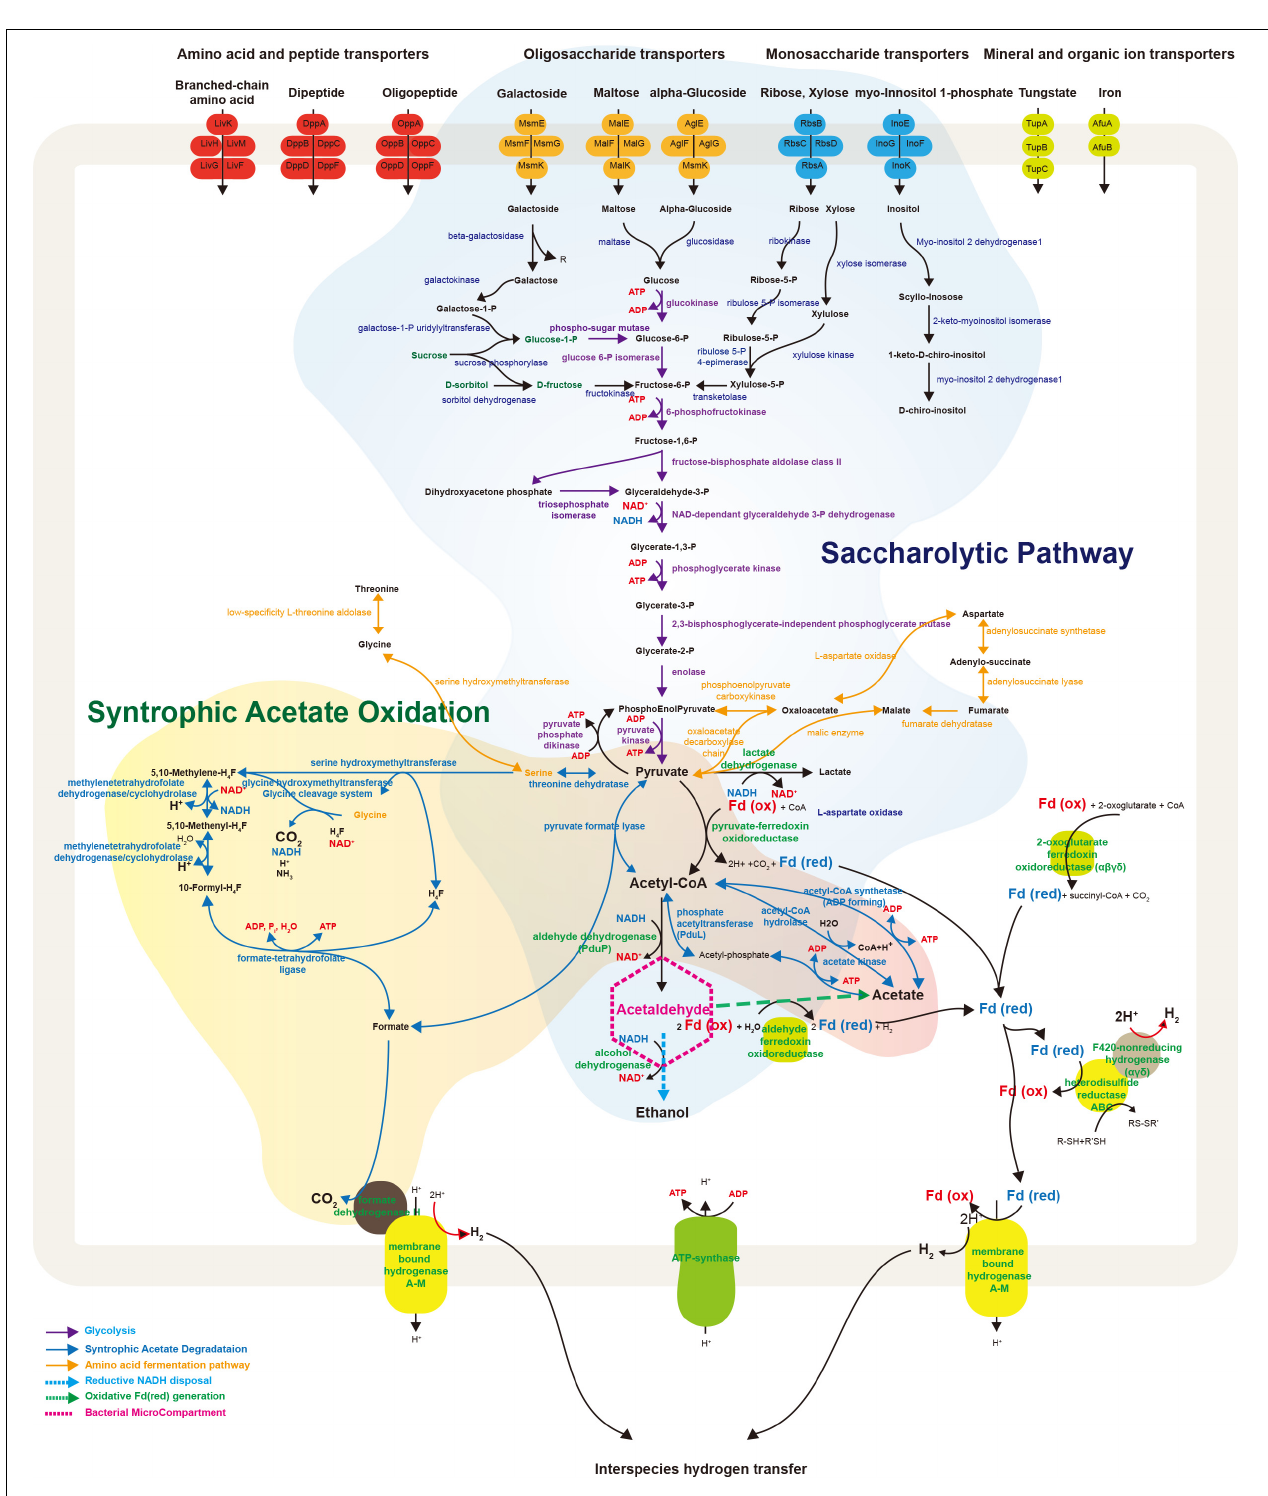
FIGURE 4 | Schematic illustration representing metabolic and transport proteins hypothesized from the genome of Ca. Atribacteria JS1. ABC transporters for specific molecules in the bacterial cell membrane are marked by color: amino acid and peptide transporters (red); oligosaccharide transporters (orange); monosaccharide transporters (blue); and mineral and organic ion transporters (green). The degradative metabolism of oligosaccharides and monosaccharides and the syntrophic acetate oxidation pathway are annotated in detail. Proteins included in this schematic of genes encoded by the RS JS1-cSAG are listed in Supplementary File 2 . CoA, coenzyme A; Fd, ferredoxin; Co, cobalamin; H 4 F, tetrahydrofolate; ATP, adenosine triphosphate; ADP, adenosine diphosphate.